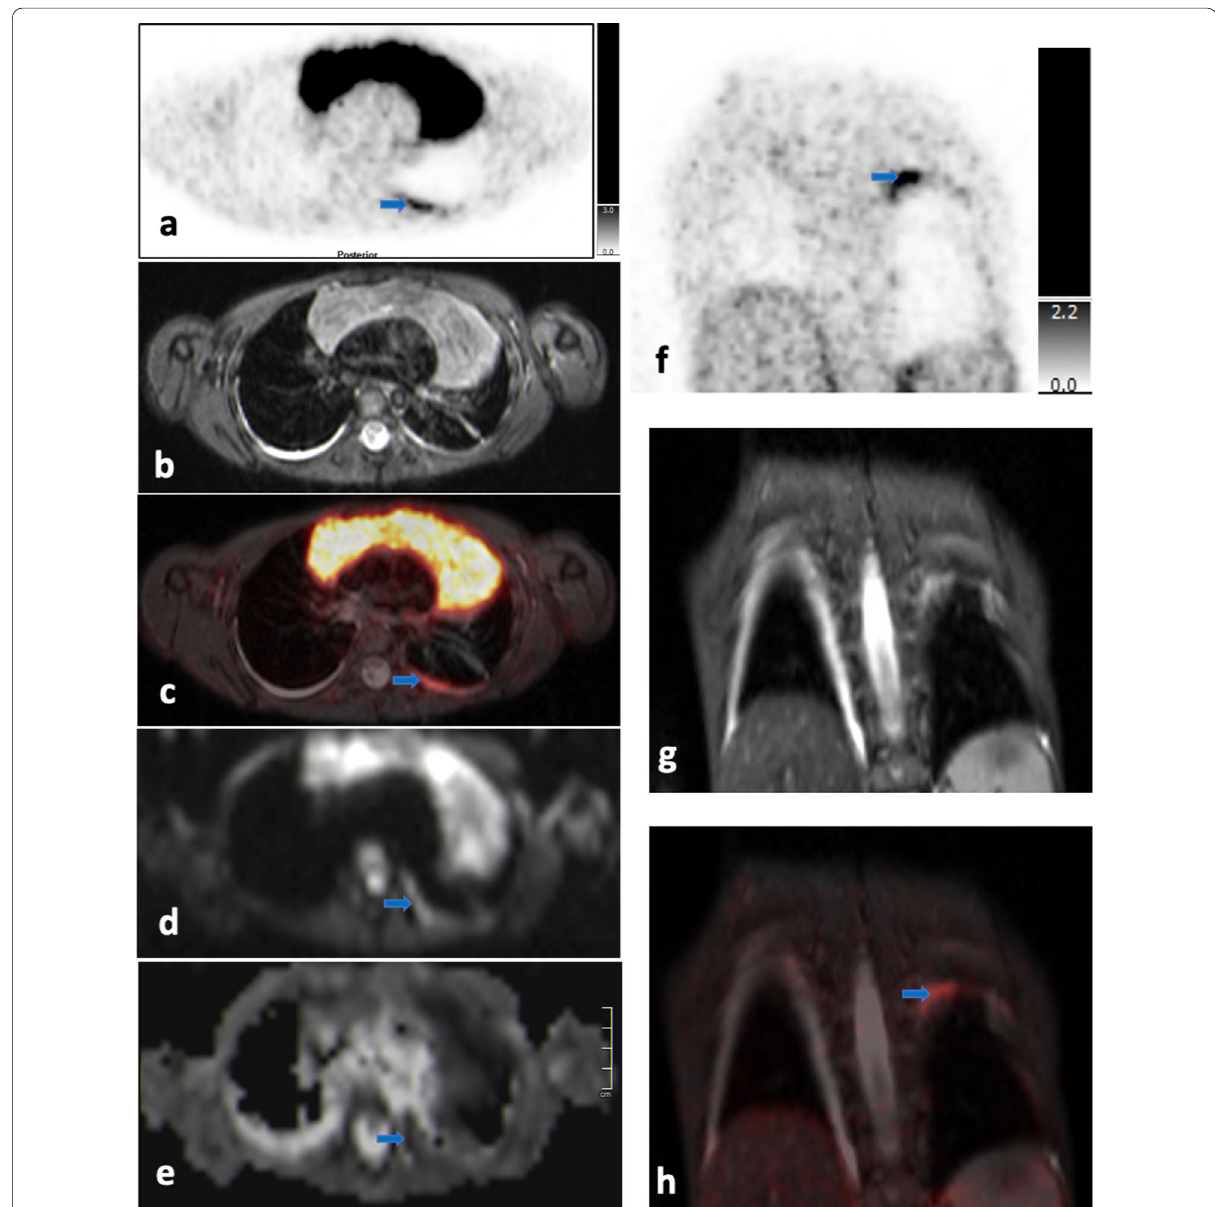
b‑value of 800 ( d,e ) of the thorax. The blue arrows point to an area of the left posterior pleura with increased glucose uptake (SUV max 2.88) ( a, c, f, h ) and a restriction in diffusion (ADC levels of about 636 10 –6 mm 2 /s) ( d, e ). This area corresponds to pleura involvement which is not distinguishable × from pleural effusion on MR T2‑TIRM images ( b, g